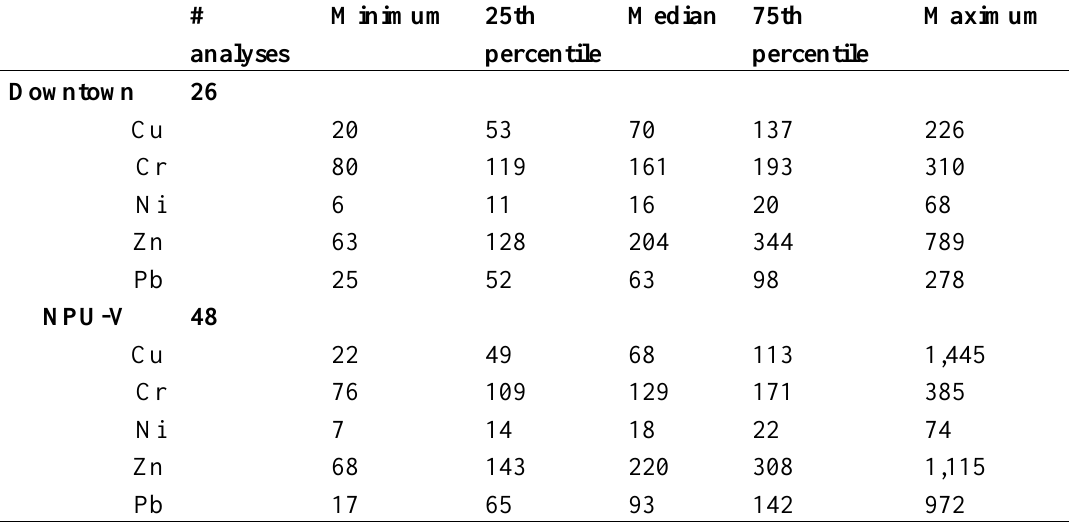
Table 1. Summary of metal analyses of road dust in Atlanta, Georgia. All units in mg/kg. #